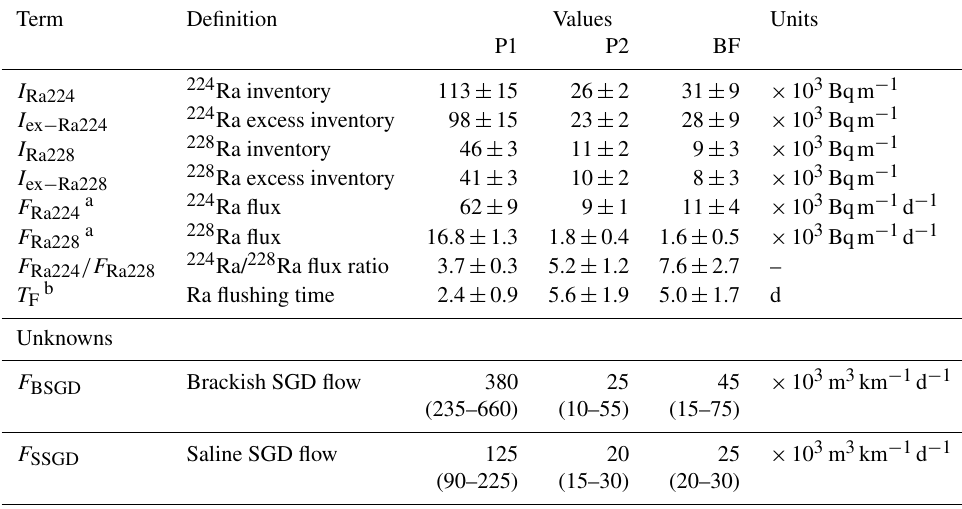
Table A1. Definition of terms, values, and units used for the Ra mass balance for each sampling (P1, P2, and BF). Data in brackets represent the interquartile range (1st and 3rd